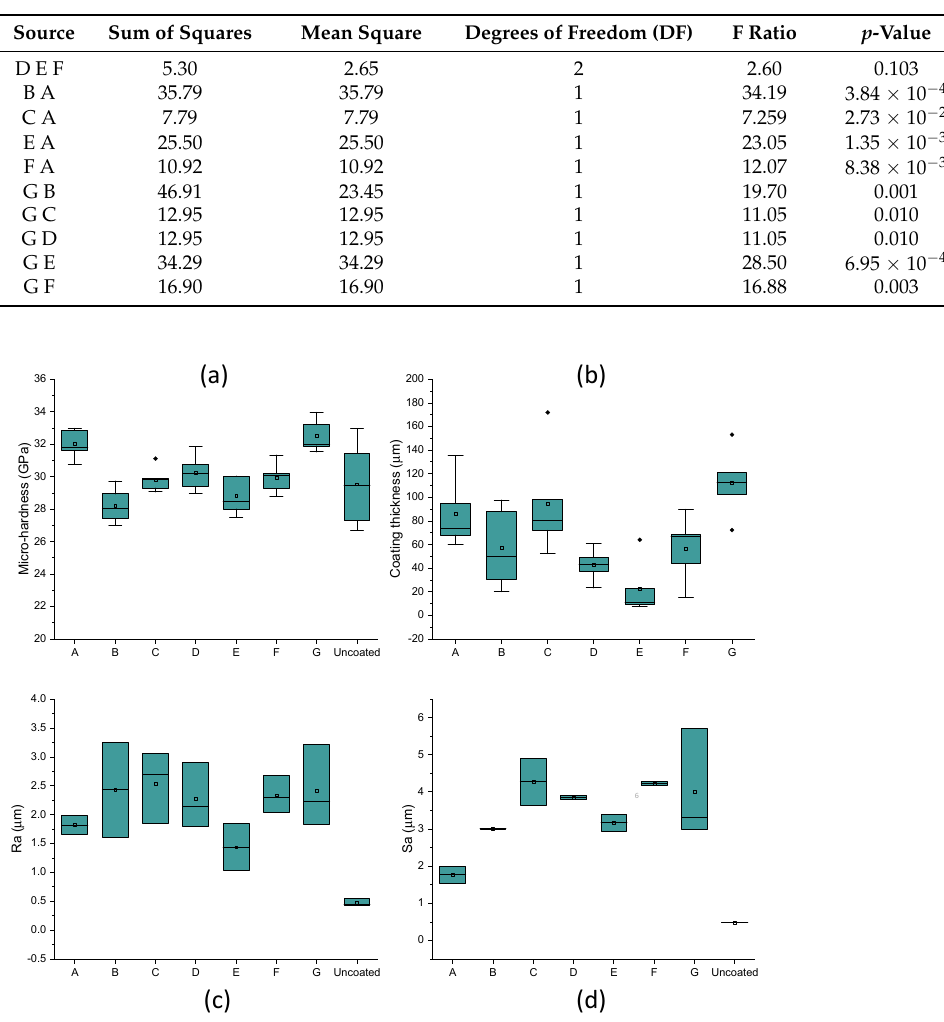
Table 3. Analysis of variance (ANOVA) results on coating micro-hardness of ultrasonic bonding experiments.